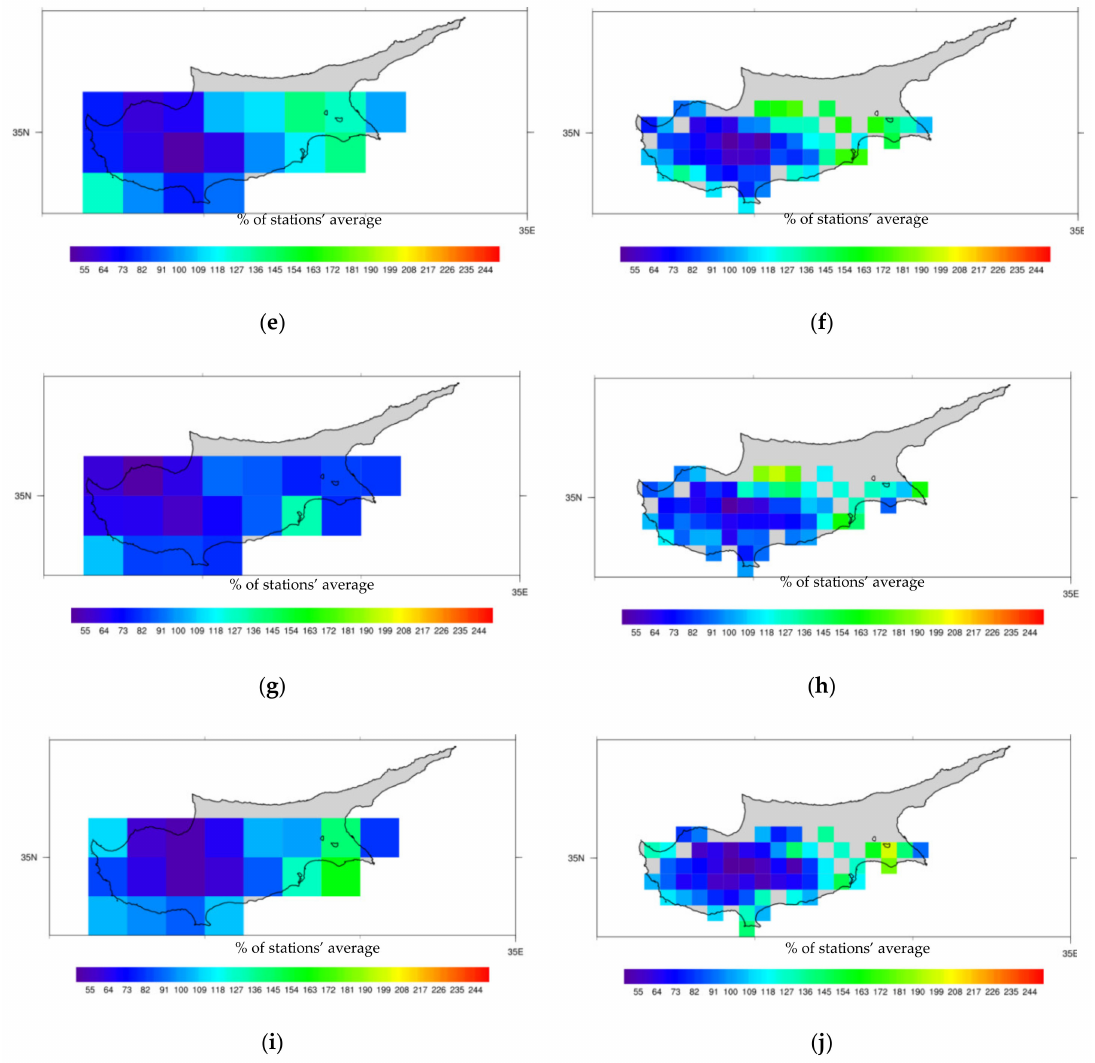
Figure 7. Underestimation / Overestimation of the annual satellite product estimates as compared with gauge station records at the corresponding grid cell: ( a ) TRMM—2014 (April–December); ( b ) GPM—2014 (April–December); ( c ) TRMM—2015; ( d ) GPM—2015; ( e ) TRMM—2016; ( f ) GPM—2016; ( g ) TRMM—2017; ( h ) GPM—2017; ( i ) TRMM—2018 (January–June); ( j ) GPM—2018 (January–June). The performance of the IMERG product was slightly better than 3B43V7 with an R higher value (0.82 and 0.81, respectively), lower Bias values ( − 17.9 mm / month and − 30.5 mm / month, respectively) and rBias values (3.1 and − 3.0, respectively), while presenting worst performance in terms of RMSE (108.8 mm / month and 94.7 mm / month, respectively) and MAE (96.1 mm / month and 83.4 mm / month, respectively) values, as presented in Table 4 (minimum and maximum respective values are provided in